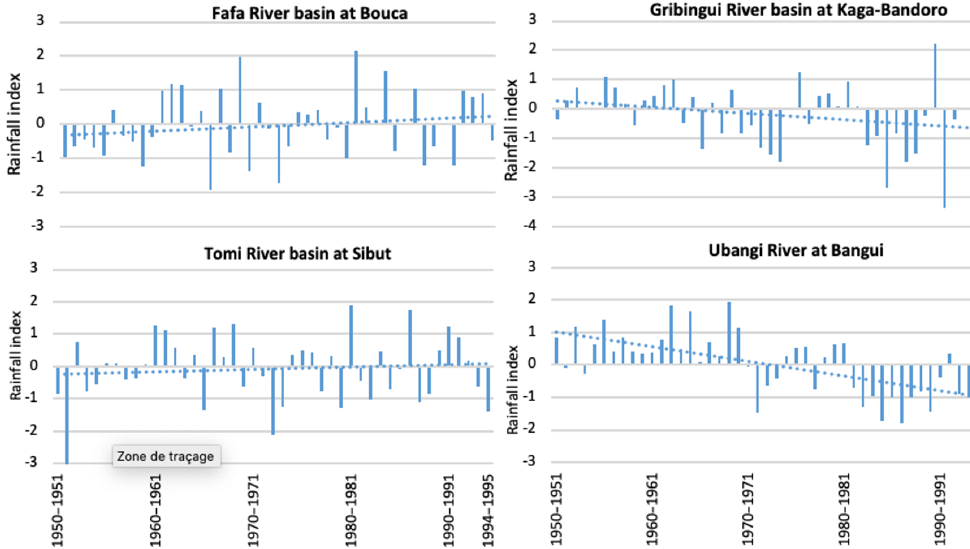
Figure 2. Rainfall index from 1950 to 1995 for 3 studied basins and the Ubangi basin at Bangui. Table 1. Years of ruptures detected in rainfall time series per